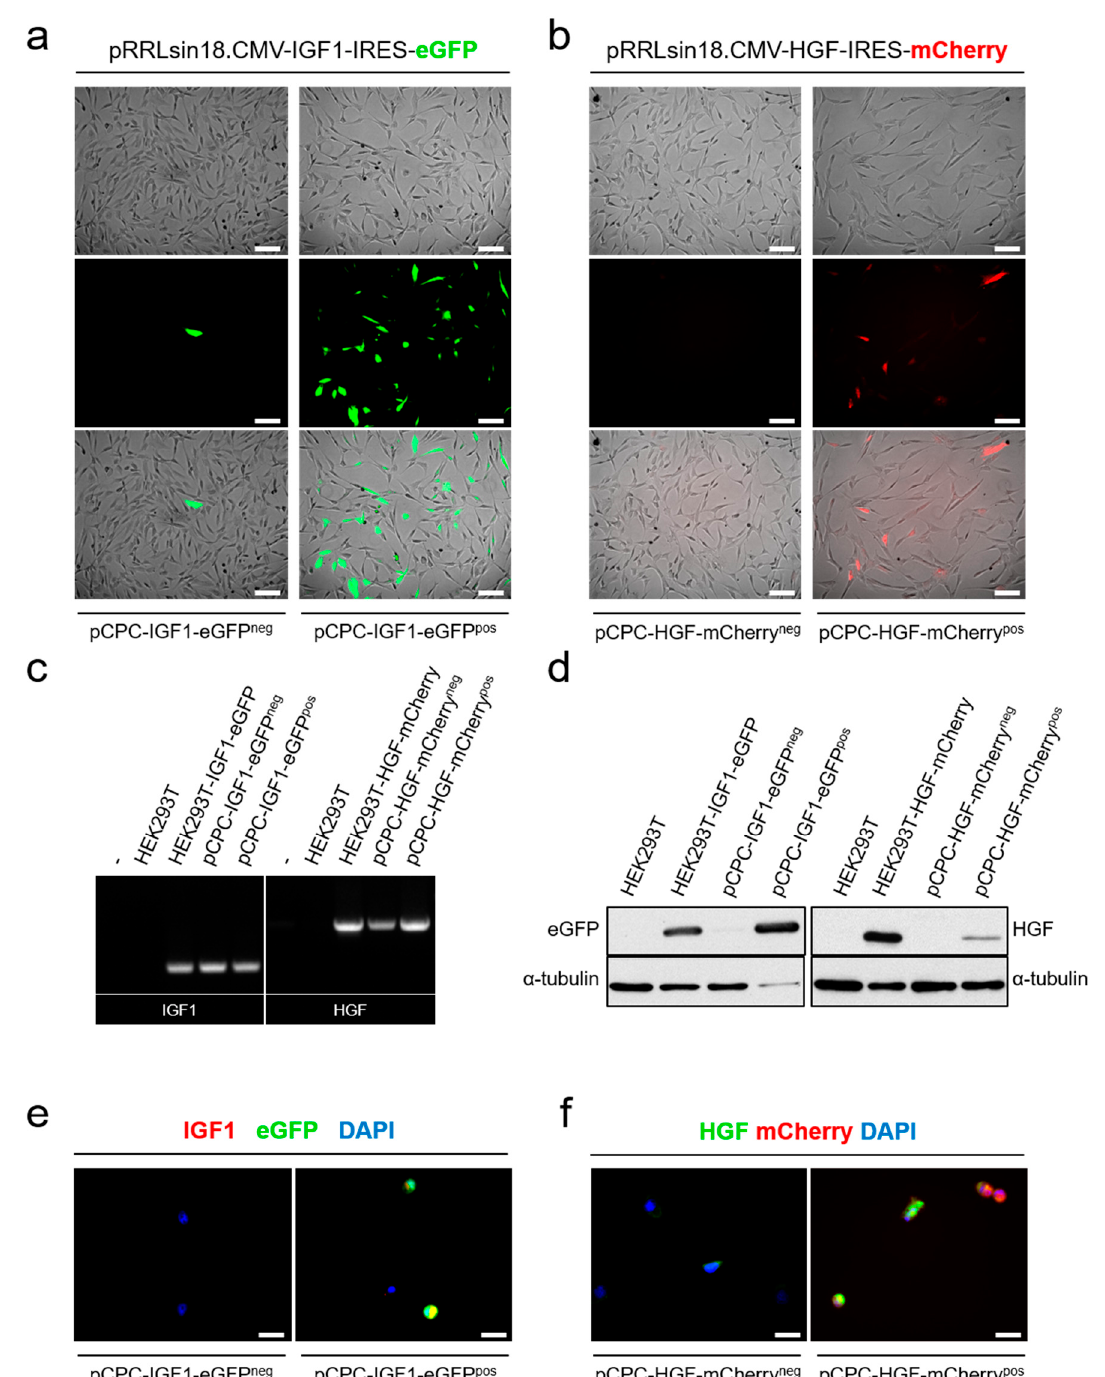
Figure 4. Expression analysis in pCPC IGF1/eGFP and HGF/mCherry transduced cells. ( a ) Fluorescent protein expression (eGFP) on transduced pCPC-IGF1-eGFP after cell sorting purification, compared with negative cell fraction. Scale bar represents 50 µm. ( b ) Fluorescent protein expression of mCherry on transduced pCPC-HGF-mCherry after cell sorting purification compared with negative cell fraction. Scale bar represents 50 µm. ( c ) IGF − 1 and HGF expression by RT − qPCR in IGF1/eGFP and HGF/mCherry engineered cells, both in HEK293T and pCPC. ( d ) eGFP and HGF overexpression analyzed by western blot in different populations of HEK293T and pCPC. ( e ) IF analysis of IGF1/eGFP expression in pCPC-IGF1-eGFP pos compared with pCPC-IGF1-eGFP neg cells. ( f ) IF analysis of HGF/mCherry expression in pCPC-HGF-mCherry pos compared with pCPC-HGF-mCherry neg cells. Scale bar represents 20 µm.